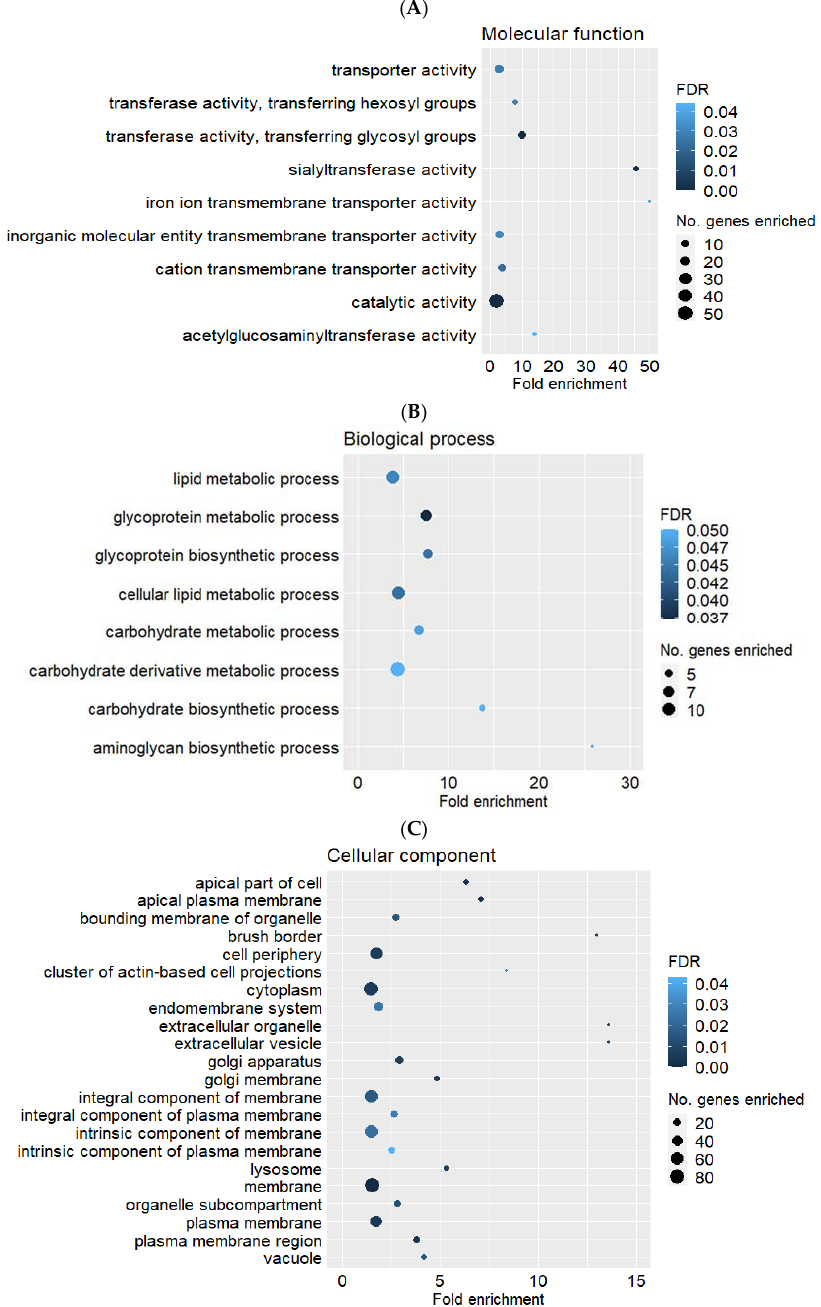
Figure 3. Gene ontology (GO) terms significantly enriched (FDR ≤ 0.05) by the downregulated genes in heat stress placentae ( n = 5) compared to control placentae ( n = 5) in the GO domains of ( A ) Molecular function, ( B ) Biological process and ( C ) Cellular component. Fold enrichment: No. genes observed in the gene list/No. genes expected.